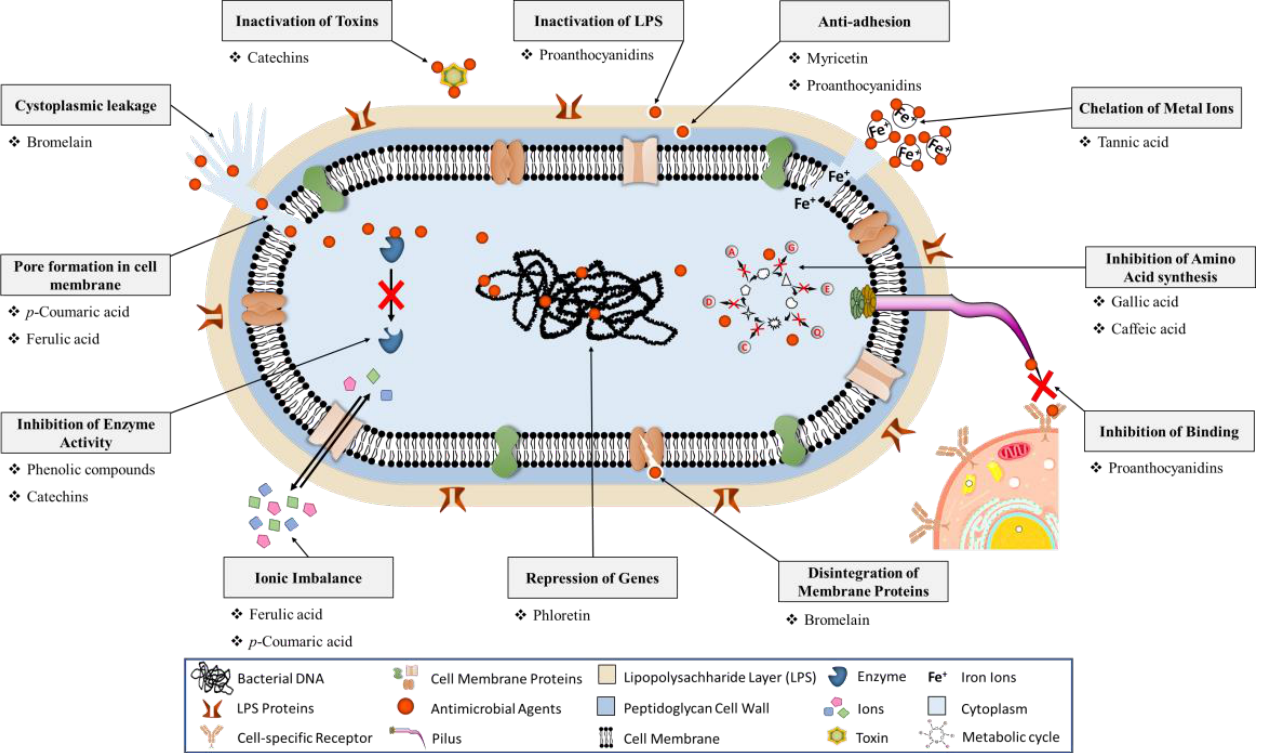
Figure 1. Antibacterial mechanism of fruit polyphenols with their target sites.